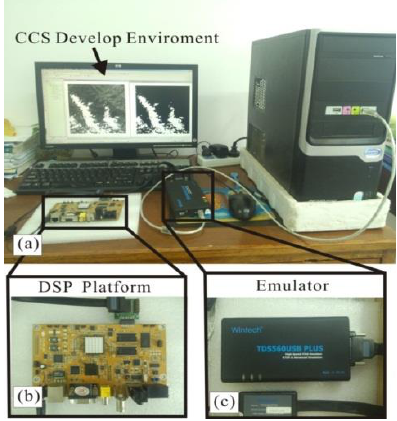
Figure 6. (a) The whole experiment platform of cloud detection. (b) DSP platform. (c)Emulator